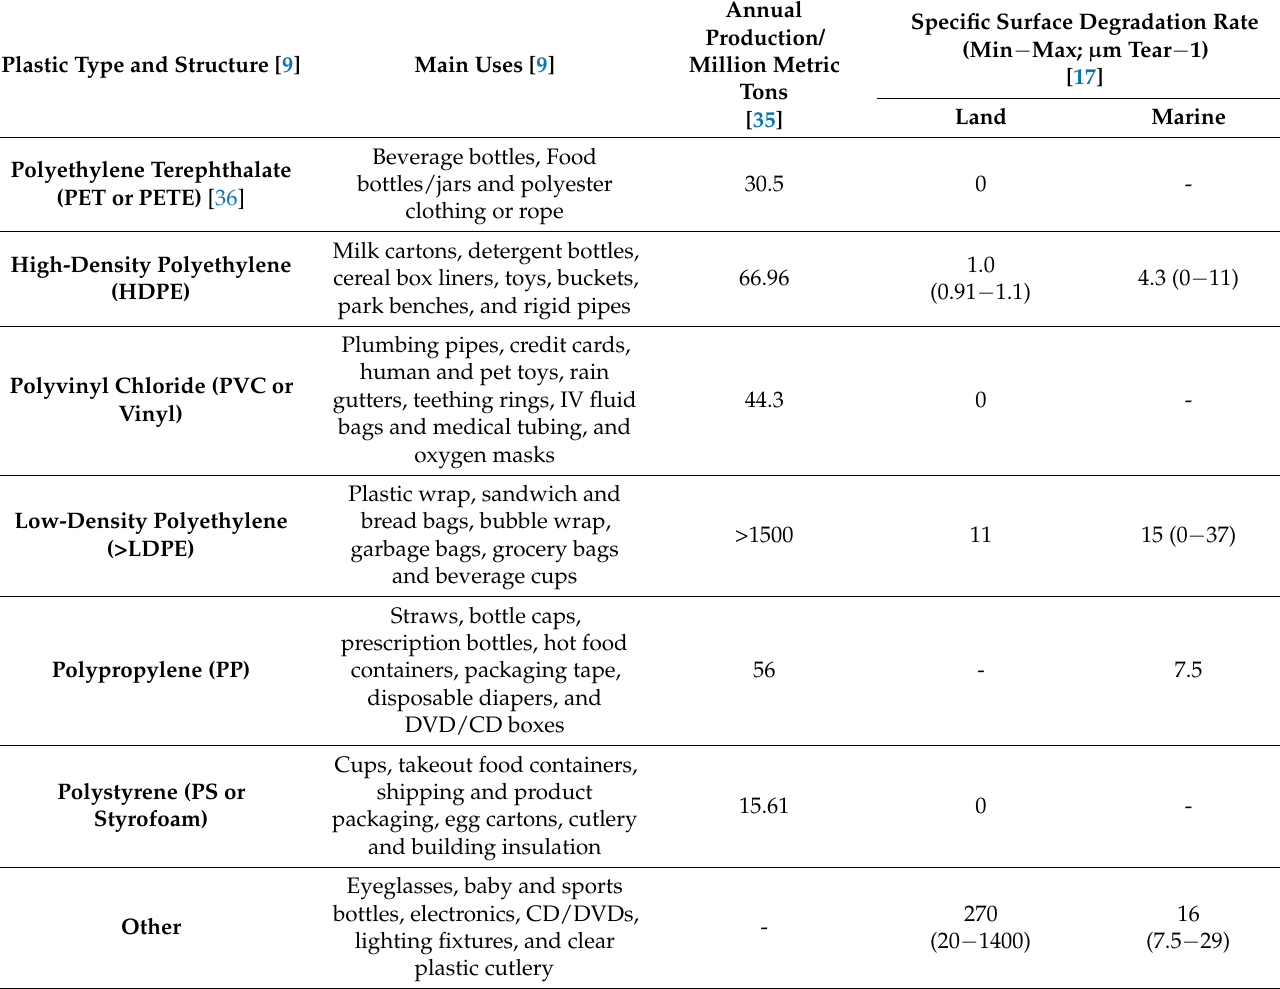
Table 1. Annual plastic production